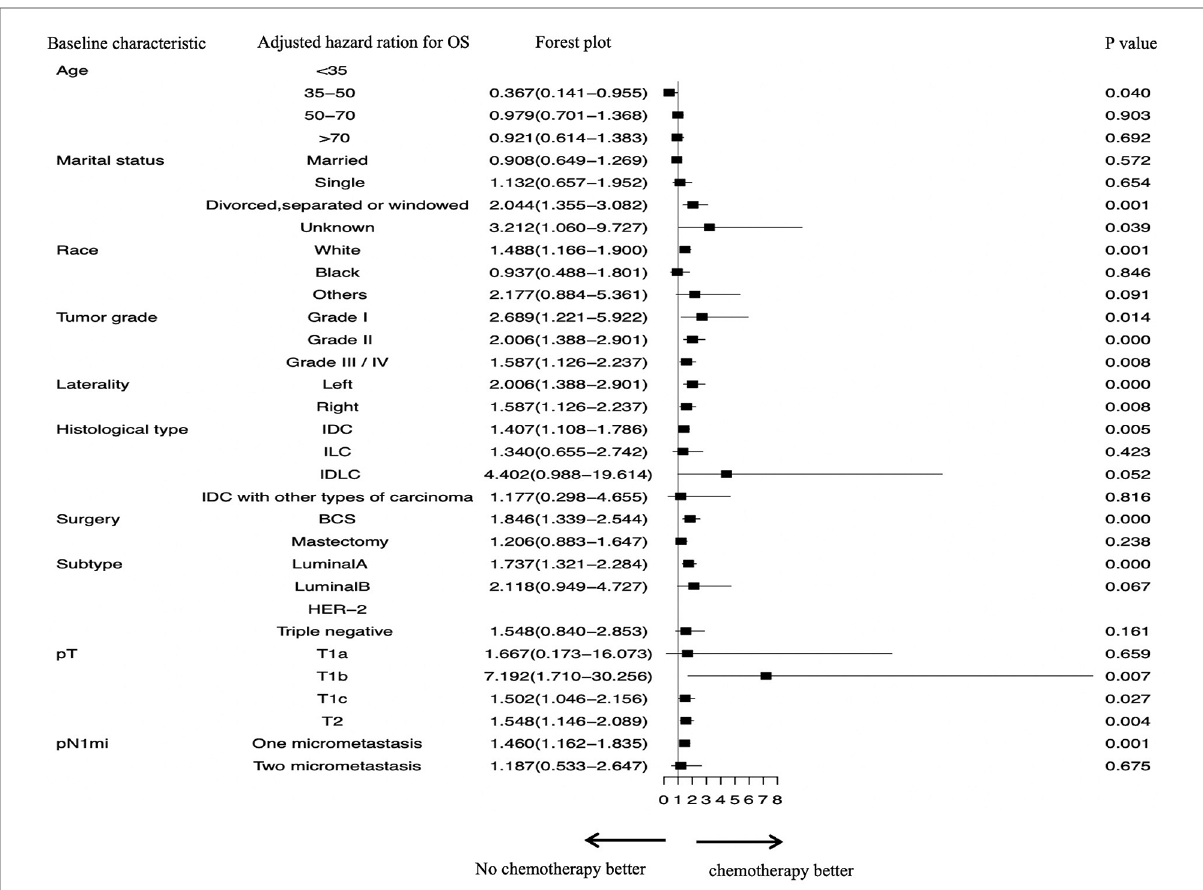
FIGURE 2 Subgroup analyses assessing the bene fi t of chemotherapy in patients who had one or two positive sentinel lymph node micrometastases and underwent sentinel lymph node biopsy alone. SLN, sentinel lymph nodal; SLNB, sentinel lymph node biopsy; IDC, invasive ductal carcinoma; ILC, invasive lobular carcinoma; IDLC, mixed invasive ductal and lobular carcinoma; BCS, breast-conserving